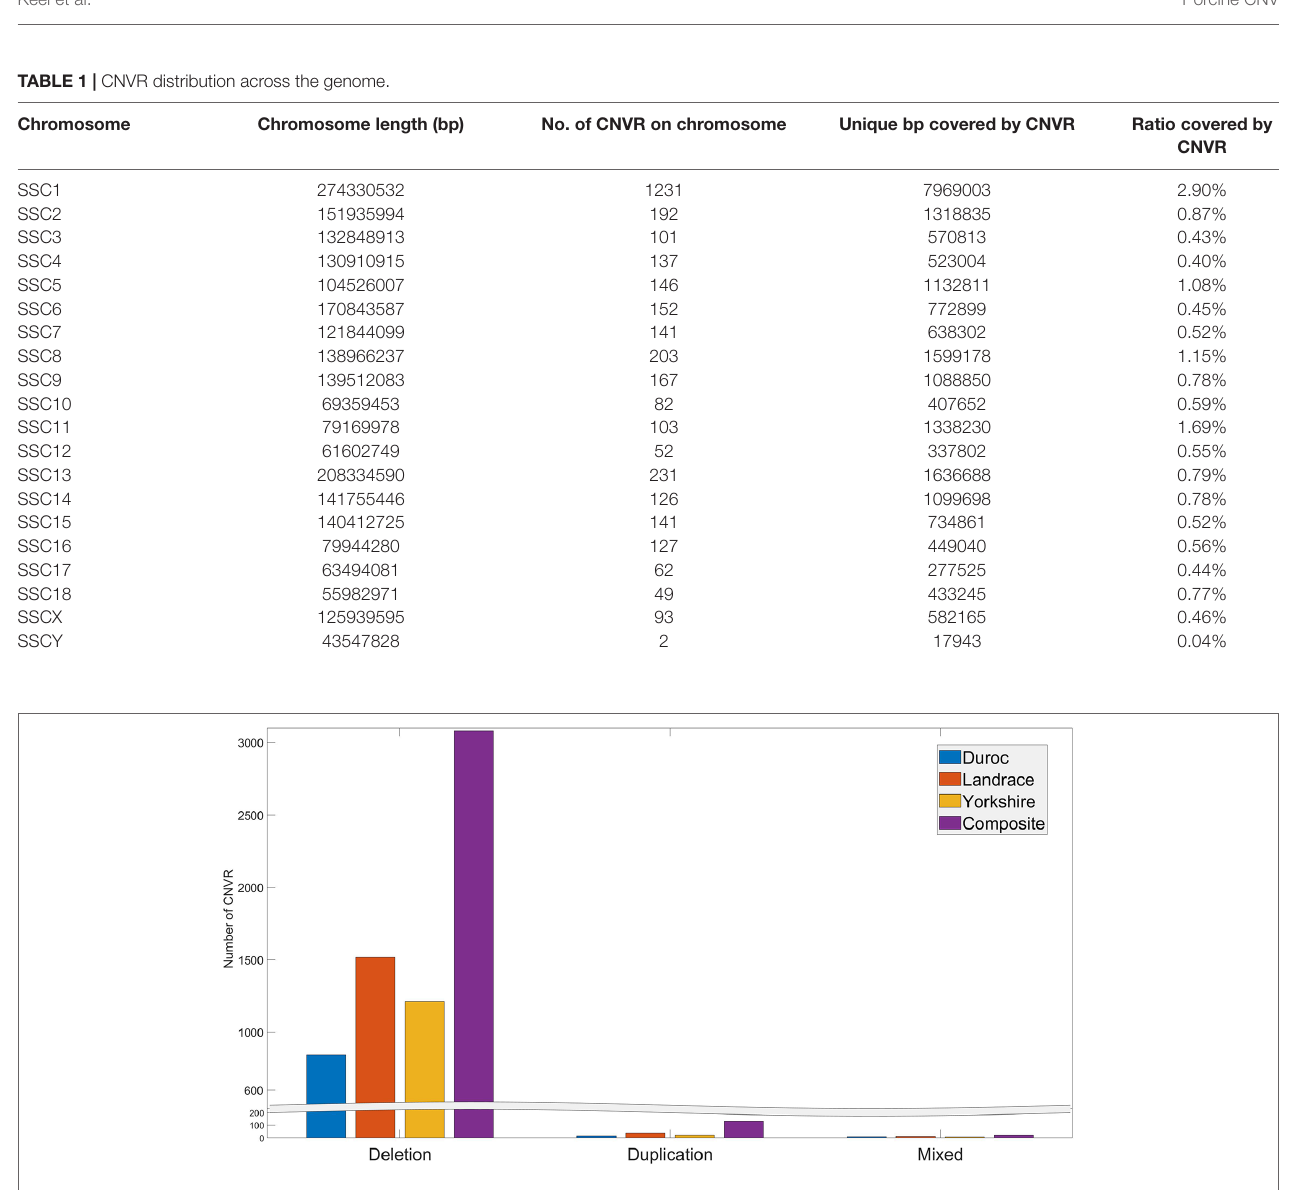
FIGURE 2 | Distribution of CNVR types across